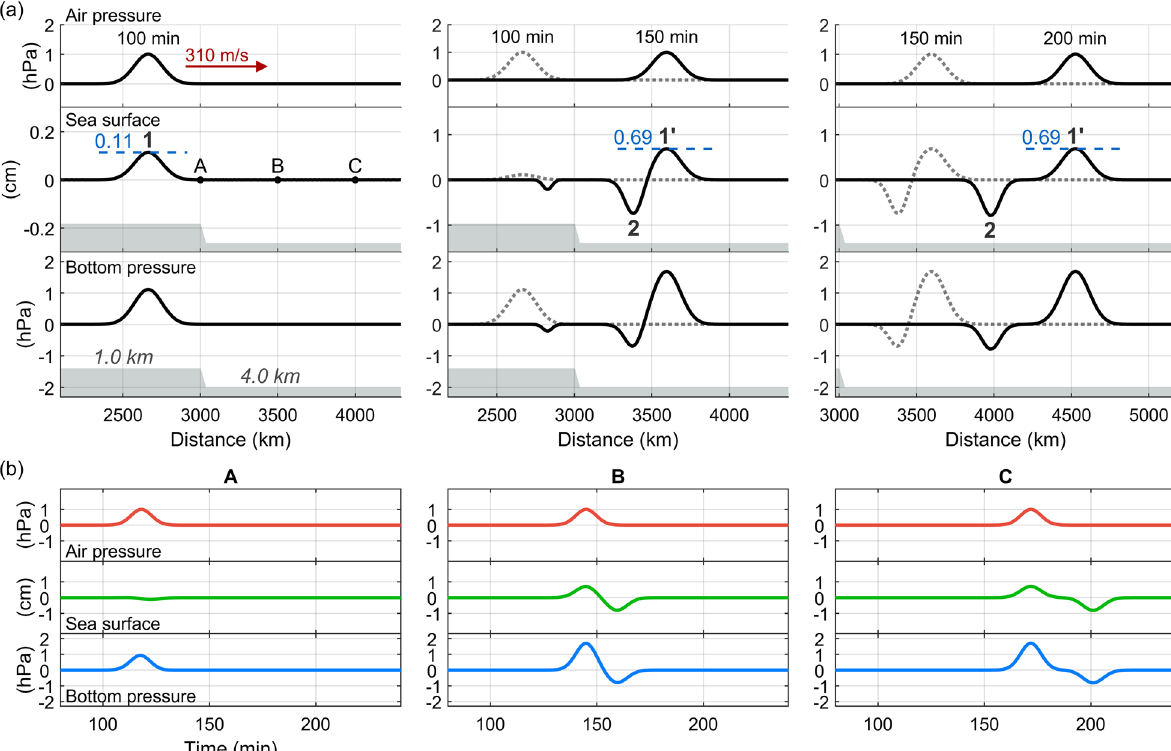
Fig. 3 The synthetic test of an air pressure wave traveling at 310 m/s passing a 5° downdip slope from 1 to 4 km depth. a The wave profiles of air pressure (upper row), sea surface (middle row), and bottom pressure (lower row) along x- direction extracted at y of the air pressure wave indicate the origin time of the snapshots of the solid or dotted lines. The waves marked with 1, 1 ′ , and 2 are the incident pressure‑forced wave, transmitted pressure‑forced wave, and the generated ocean gravity wave, respectively. A, B, and C in the left column indicate the locations where we measured the time‑series waveforms shown in b . b The waveforms at locations A (left), B (middle), and C (right). The red, green, and blue lines represent the waveforms of the air pressure wave, sea surface height, and bottom pressure,